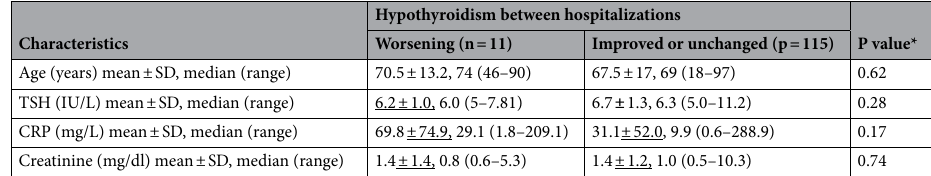
Table 4. Hypothyroidism worsening between hospitalizations and clinical characteristics in the first hospitalization. CRP C-reactive protein, CRE creatinine. *Kruskal Wallis Test. *Wilcoxon sum rank test